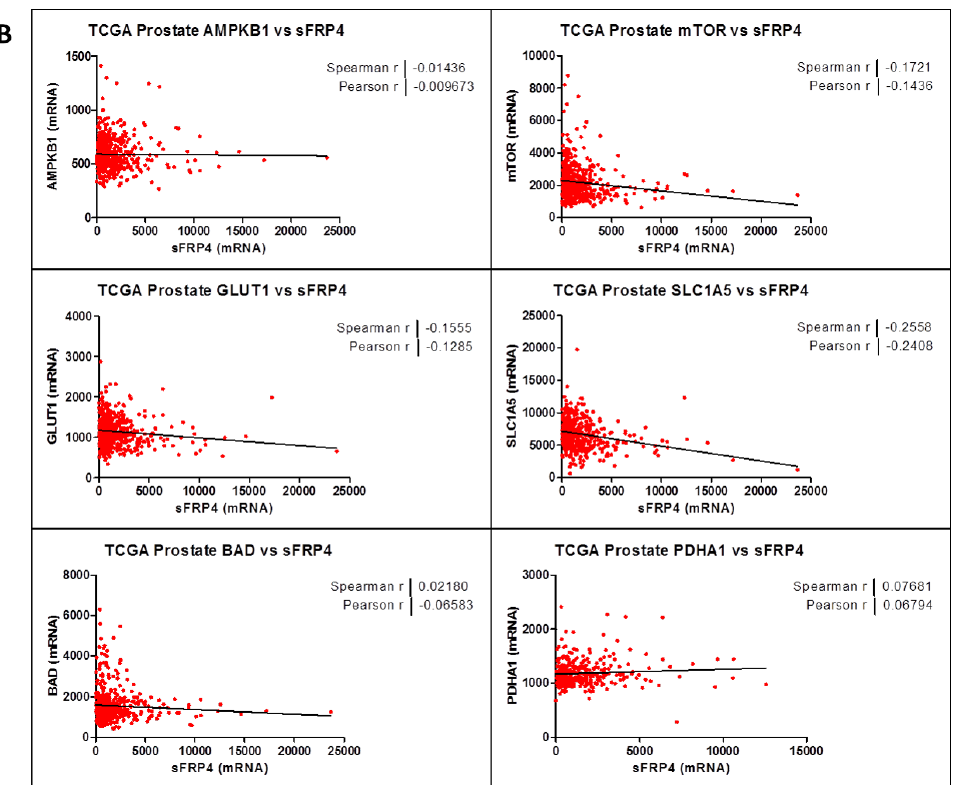
Figure 3. Correlation coefficient of sFRP4 with metabolic gene-set: Spearman and Pearson correlation coefficient between the mRNA expression values from TCGA patient tumour data. ( A ) Breast Invasive Carcinoma ( n = 825) and ( B ) Prostate Adenocarcinoma ( n =